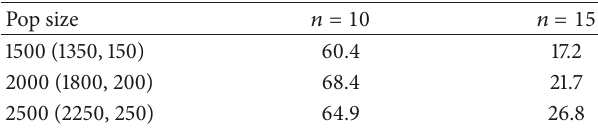
Table 5: Percentage of PDS in the final population for the two- population concurrent search approach on 𝑀 = 5 .